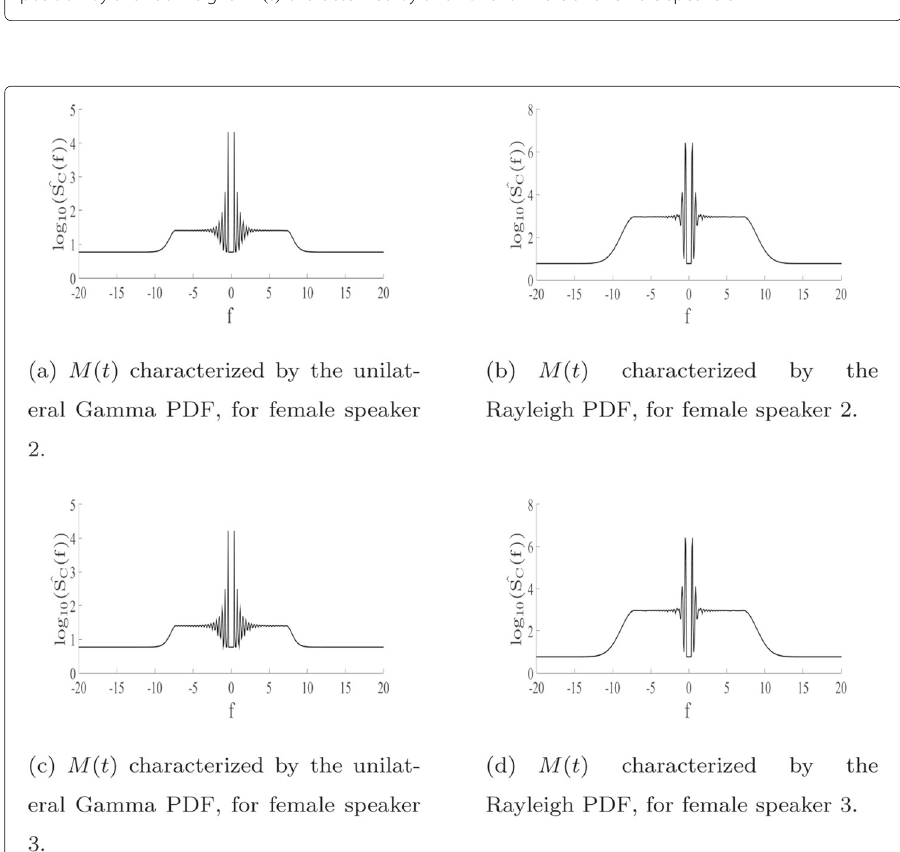
Fig. 8 PSD estimates, log 10 ( ˆ S C ( f )) ( db ) , as a function of f ( × π rad/s ) , an impulse train modulated in position by a random signal M ( t ) characterized by two PDFs for female